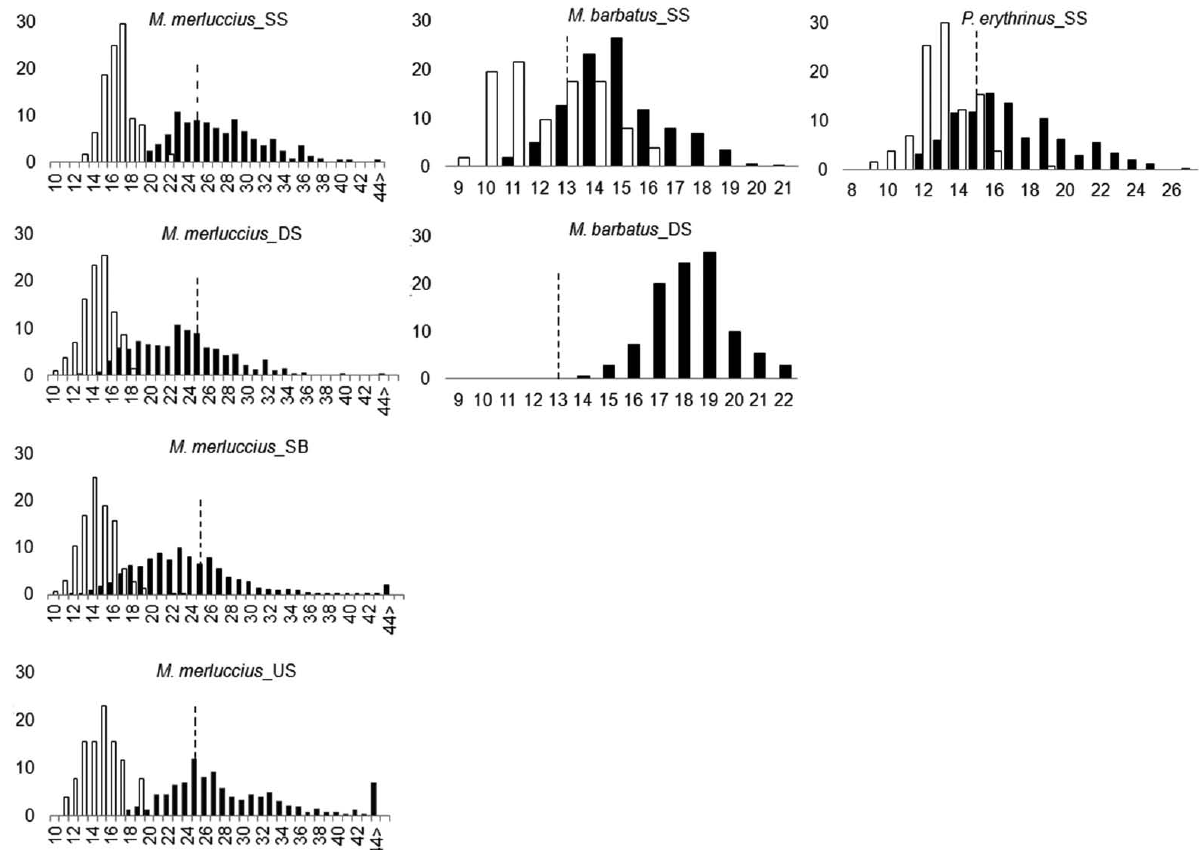
Fig. 4. – Size composition of M. merluccius, M. barbatus and P. erythrinus by depth strata (SS, shallow shelf; DS, deep shelf; SB, shelf break; US, upper slope), showing the landed (black bars) and discarded (white bars) fractions. The discontinuous line shows the current minimum legal landing